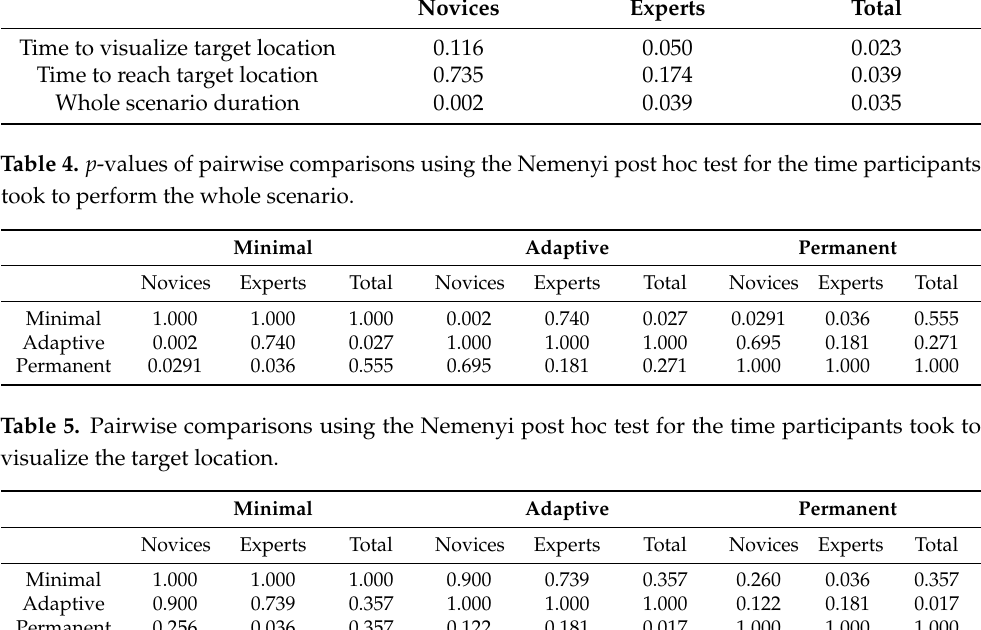
Table 3. Friedman p -values of the different efficiency metrics comparison between guidances. Novices Experts